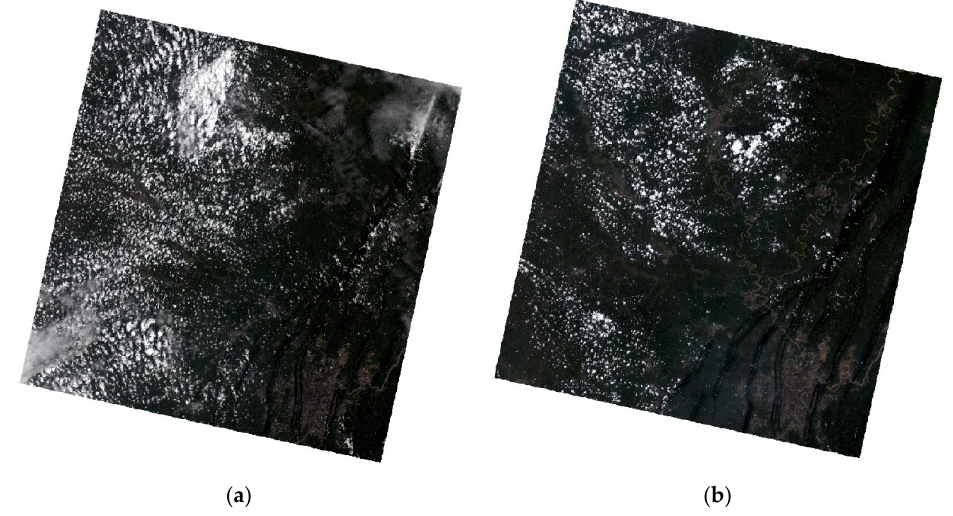
Figure 2. Different cloud-cover Landsat OLI data. ( a ) Cloudiness: 26.28%; ( b ) Cloudiness: 8.43%. Figure 2. Di ff erent cloud-cover Landsat OLI data. ( a ) Cloudiness: 26.28%; ( b ) Cloudiness: